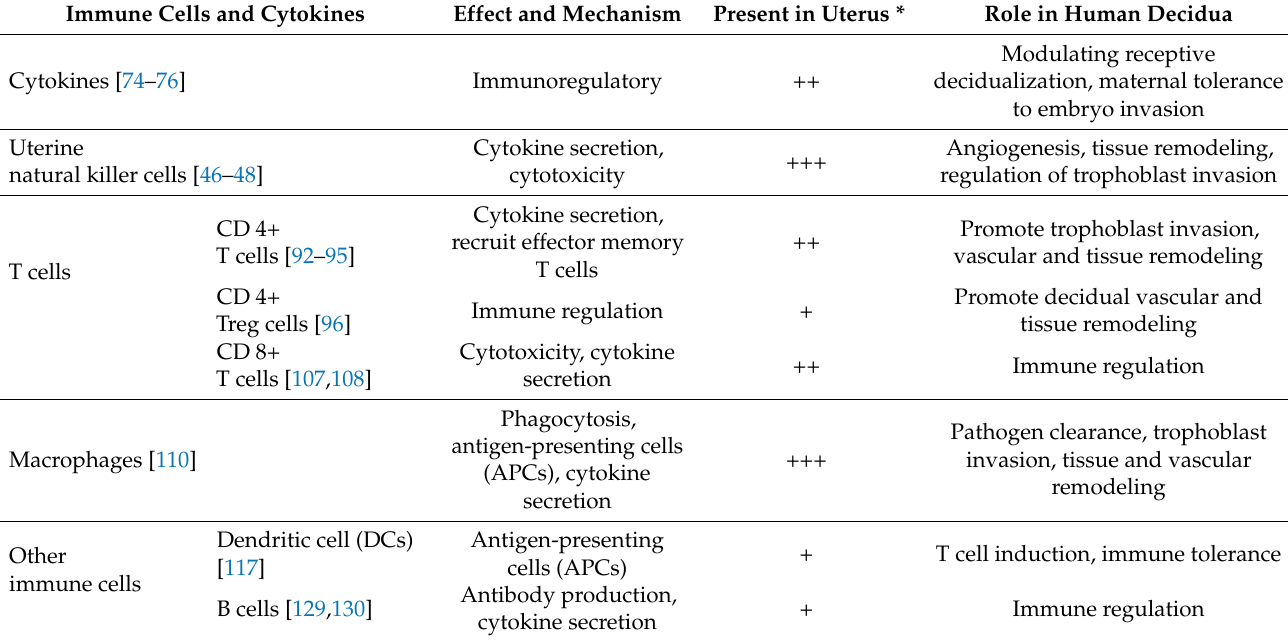
Table 1. The roles of immune cells and cytokines in human